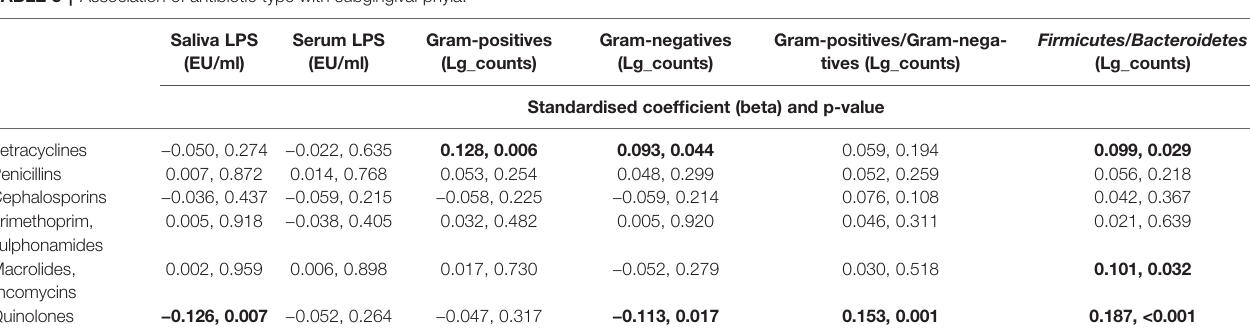
Linear regression model adjusted for age and sex. Antibiotics are categorised as: not within 1 year; once within 1 year; ≥ twice within 1 year. All bacterial levels are log-transformed. EU, endotoxin units. Signi fi cant p-values are in bold